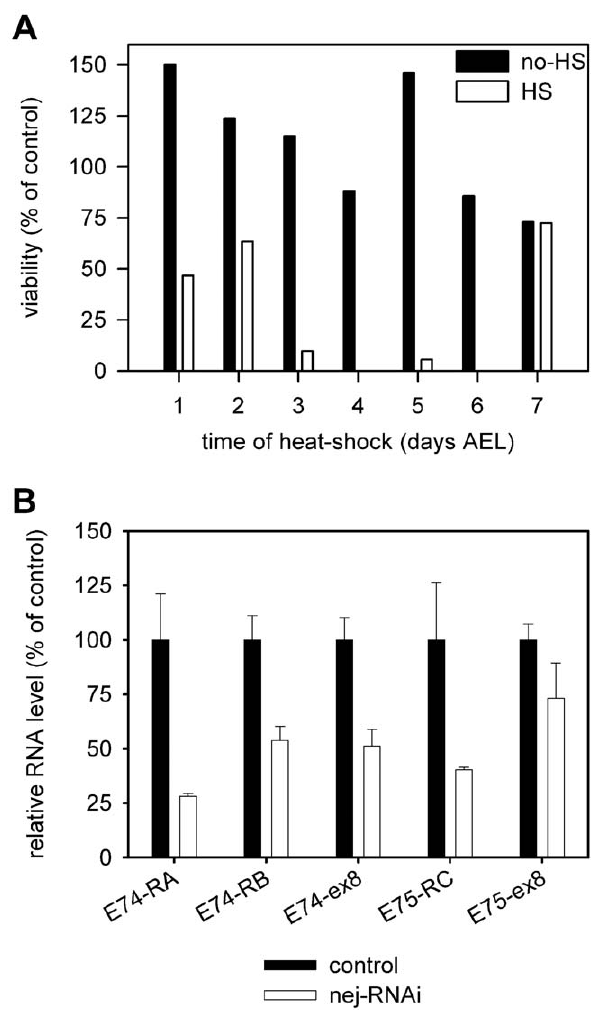
Figure 5. dCBP is required for larval development and ecdysone induced gene expression. (A) Heat-shock activated one-off expression of a UAS-nejire-RNAi construct in hs-GAL4 . UAS- nej-RNAi animals (empty bars) reduces viability compared to non-heat- shocked controls (filled bars). Especially strong effect could be observed if the heat-shock was administered between days 3 and 6 after egg laying. Viability is expressed as the ratio of the number of eclosed hs- GAL4 . UAS-nej-RNAi flies and UAS-nej-RNAi non-expressing control siblings. (B) The level of Eip74EF and Eip75B specific transcripts is decreased in nej-RNAi expressing hs-GAL4 . nej-RNAi wandering L3 larvae (empty bars) compared to non-expressing control siblings (filled bars). Quantitative PCR analysis was performed with intronic primer pairs specific for the Eip74EF-RA , -RB or Eip75B-RC promoters (E74-RA, E74-RB and E75-RC, respectively), and with primer pairs located in downstream exons detecting mRNA products of the two genes (E74- ex8 and E75-ex8). The chart shows the relative RNA quantities normalized to transcript levels in non-expressing controls 6 s.d.